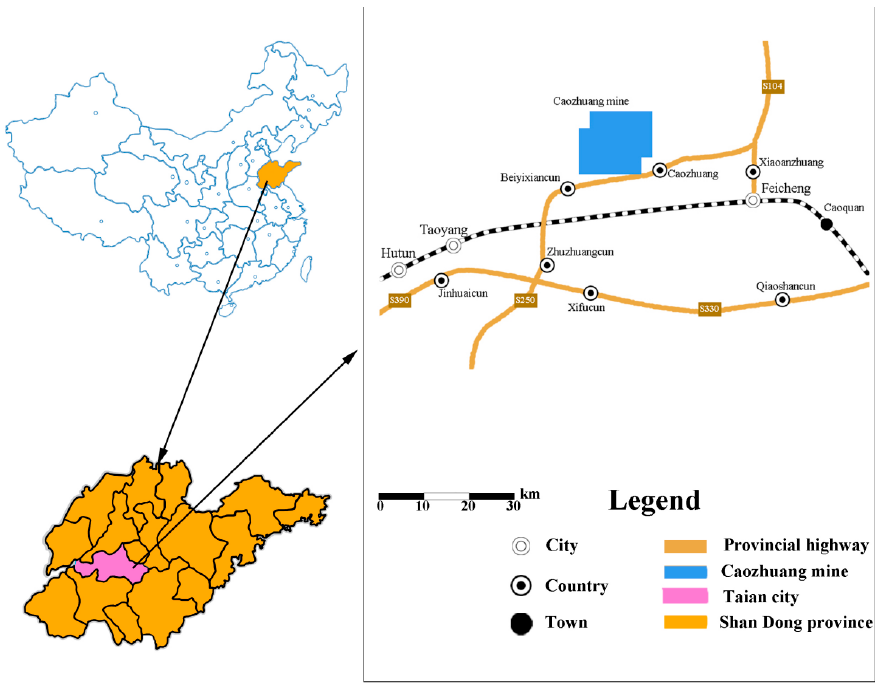
Figure 1. The location of Caozhuang Coal Mine.